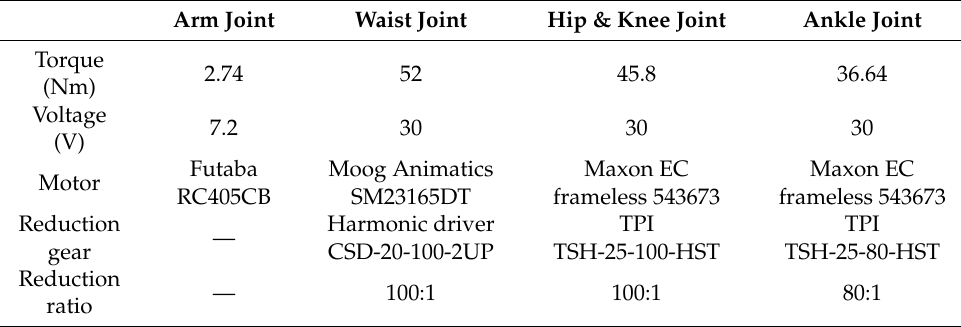
Table 2. Specifications of robot